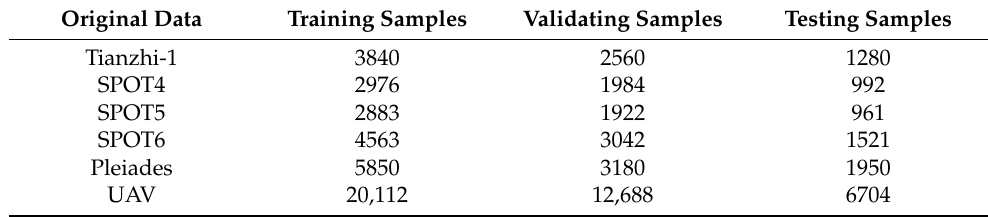
Table 2. The information of the dataset, generated from the plain